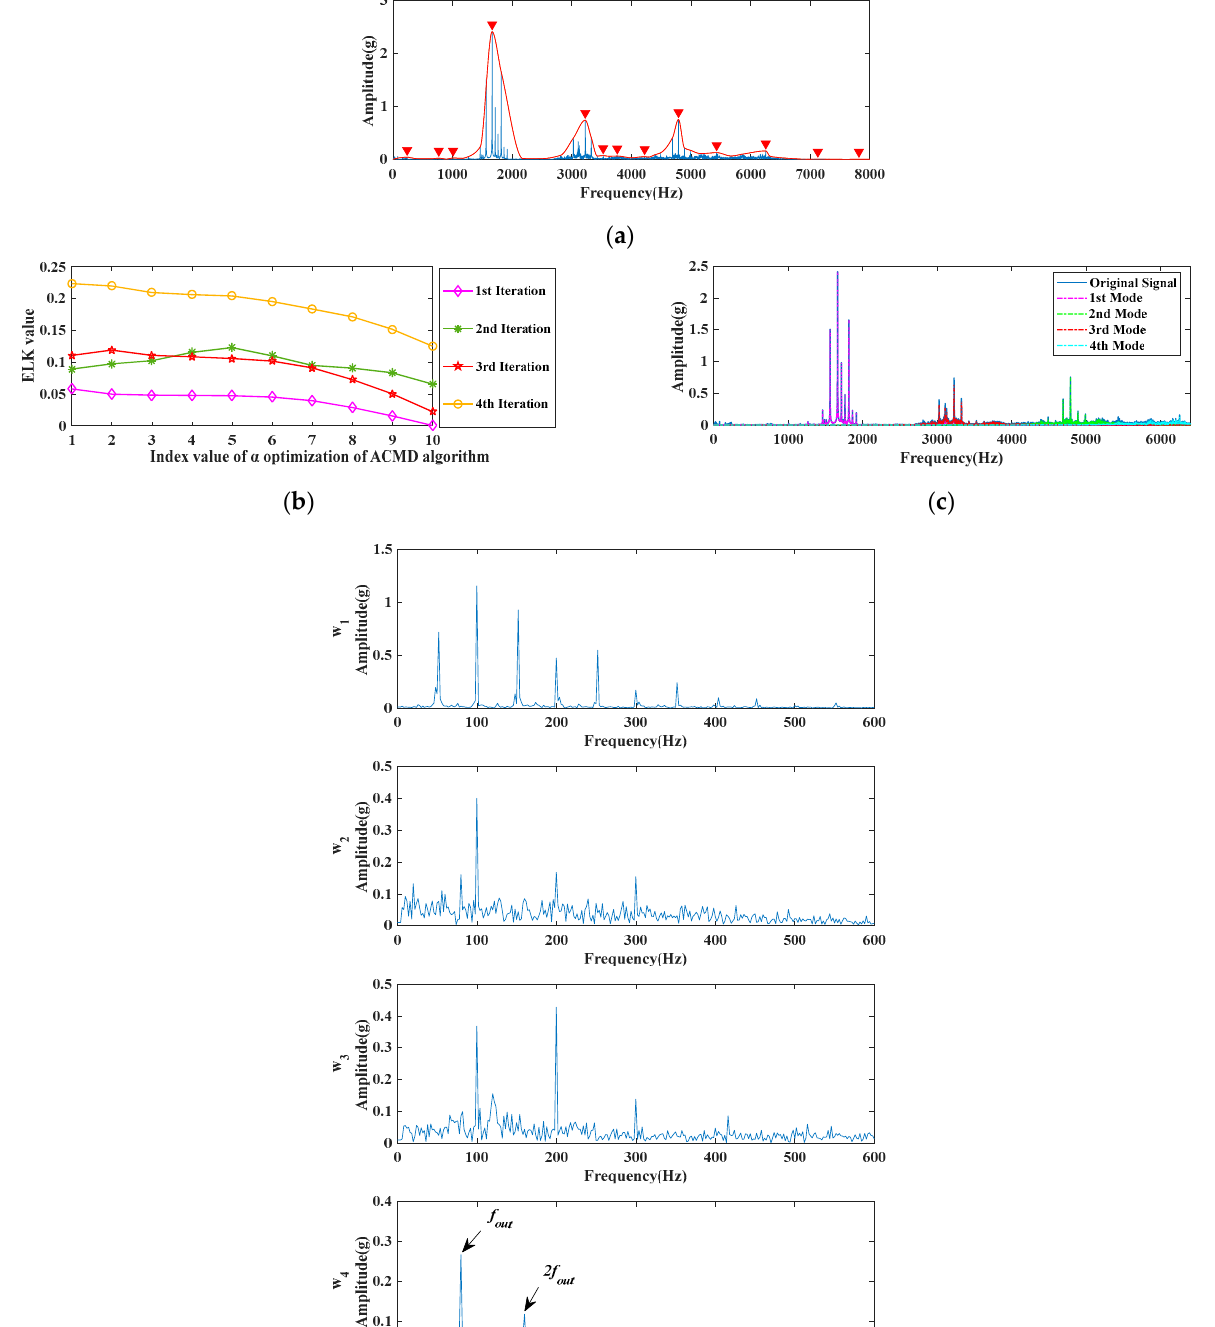
Figure 24. Engineering fault signal: ( a ) waveform; ( b ) frequency spectrum; ( c ) envelope spectrum.